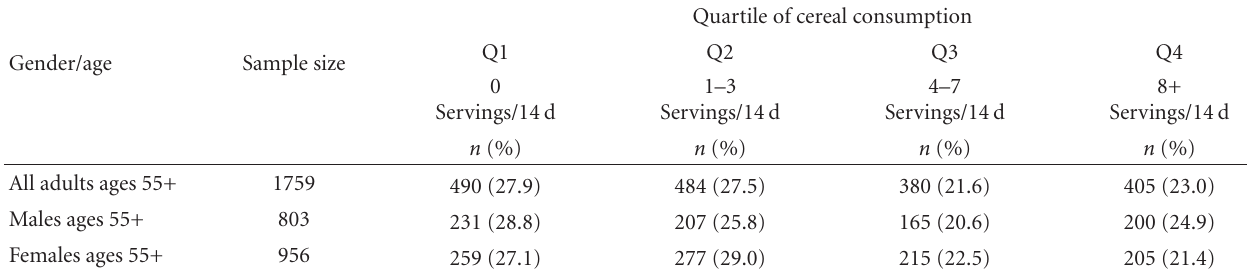
Table 1: Sample size and RTE cereal consumption distribution for adults 55+ from the 2007-2008 NET survey.